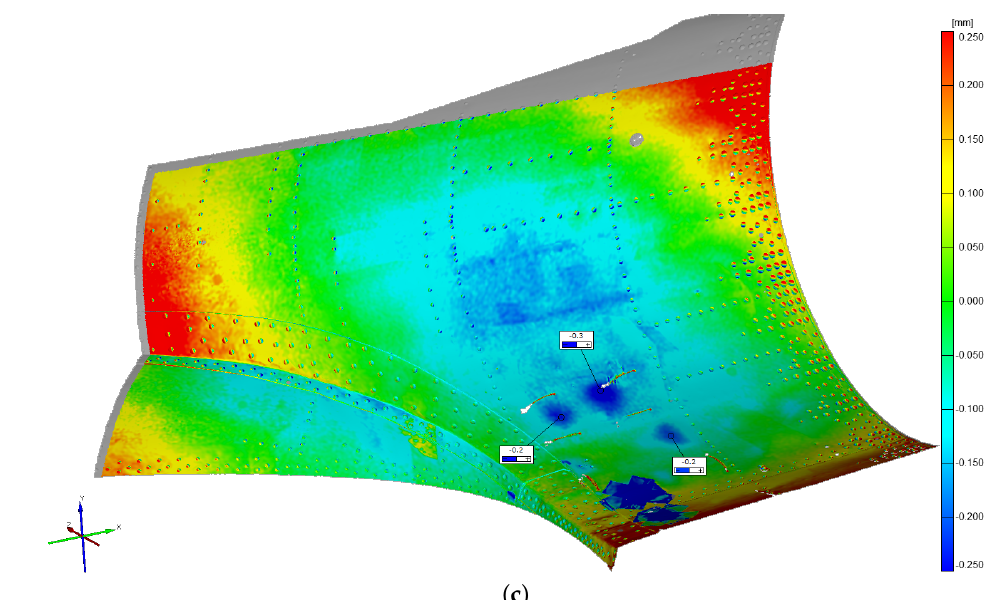
Figure 15. Optical scans of the fuselage skin after the 0.78 m drop. MLG attachment zone, right ( a ) and left ( b ); tail boom-fuselage connection ( c ).